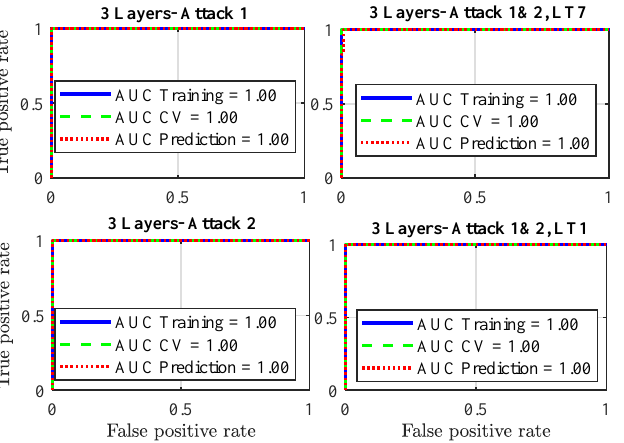
Figure 5. The ROC of various attack scenarios without any measurement noise, using shallow neural network detection algorithm.